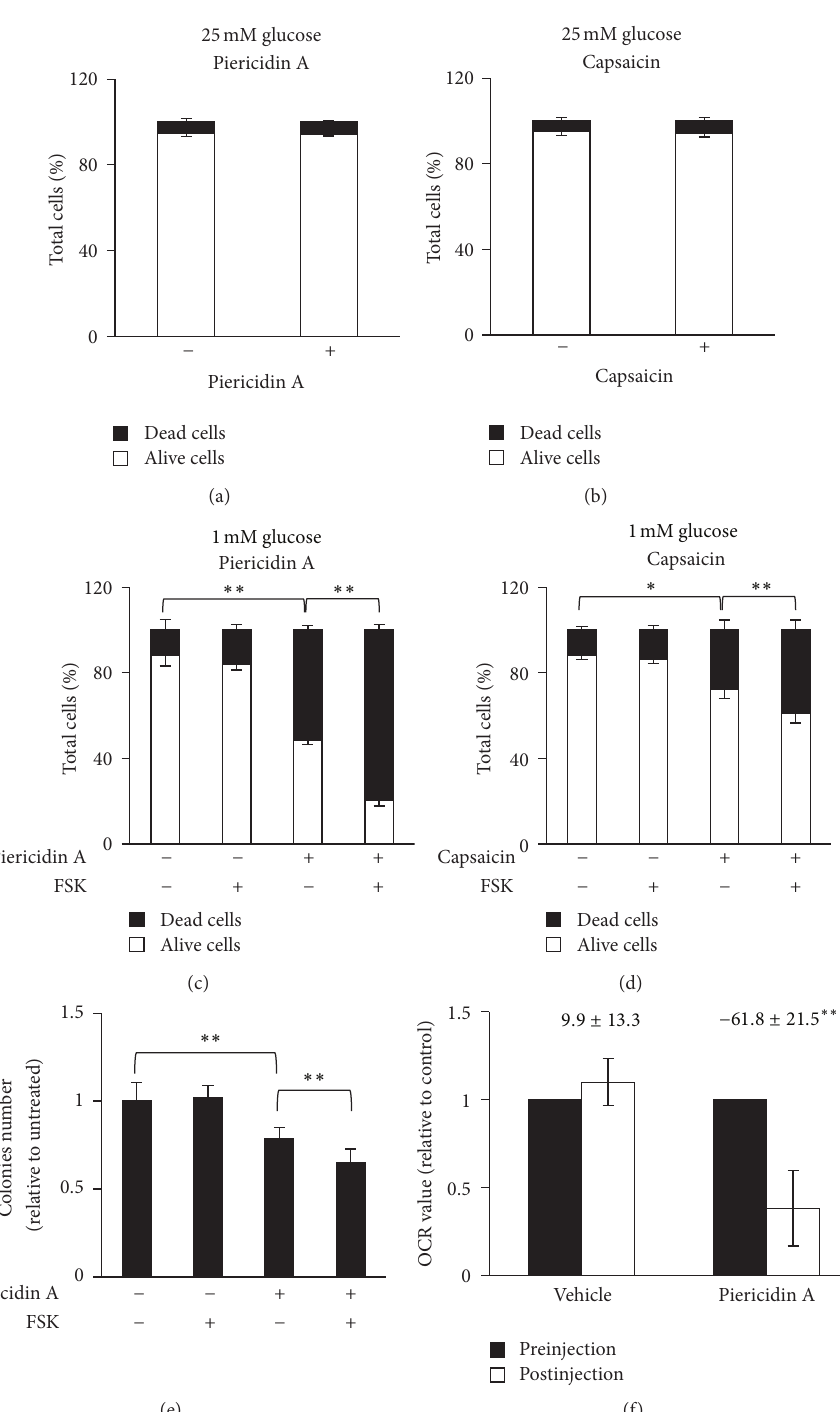
Figure 4: The mitochondrial Complex I inhibitors piericidin A and capsaicin induce cell death in MDA-MB-231 cells as observed with rotenone. Viable cell count using Trypan Blue was performed after treatment with 5nM piericidin A or 100 𝜇 M capsaicin at 48 hours of culture in different growth conditions. (a)-(b) MDA-MB-231 cells were cultured in 25 mM glucose and counted after 2-hour treatment with piericidin A (a) or capsaicin (b). (c)-(d) MDA-MB-231 cells were cultured in 1mM glucose and treated with (c) piericidin A or (d) capsaicin, 10 𝜇 M FSK, or FSK together with Complex I inhibitors. In the last case, cells were pretreated with FSK for 1 hour and then piericidin A or capsaicin were added for 2 hours (see Figure 2(c) as example). After treatment cell count was performed. (e) After treatment with piericidin A 3 × 10 3 cells were plated in normal growth medium for clonogenic assay and after ≥ 12 days colonies were stained and counted. (f) OCR of MDA-MB-231 cells cultured in low glucose was determined by Seahorse XF24 analyzer 30 minutes after injection of vehicle or 5nM piericidin A; the percentage of OCR variation after injection is reported. All data represent the average of at least three independent experiments ( ± s.d.); ∗ 𝑃 < 0.05 , ∗∗ 𝑃 < 0.01 (Student’s 𝑡